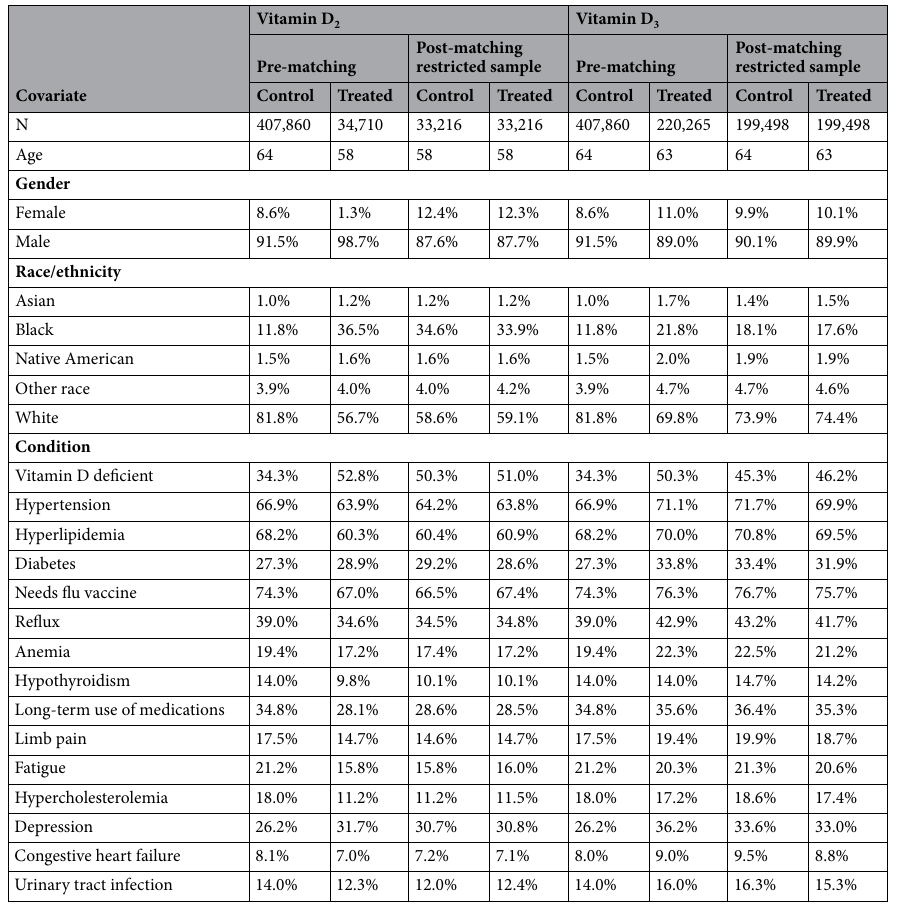
Table 1. Patient sample before and after matching. Treated beneficiaries include all beneficiaries that received vitamin D3 between January 1, 2019 and December 31, 2020 except for beneficiaries that received treatment after infection with COVID-19. These beneficiaries were considered as controls, as were those beneficiaries that never received treatment. Source: VA and Medicare Claims